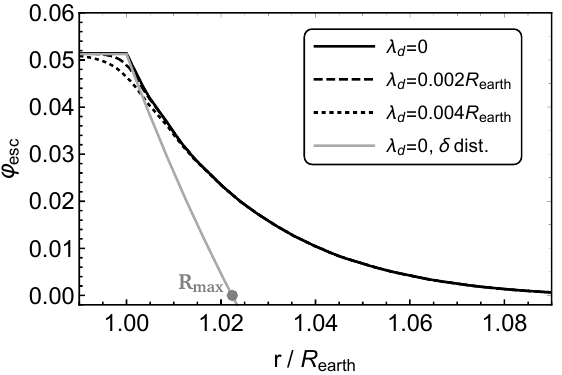
Figure 9 . Mirror electric potential ϕ esc ( r ) in the disk case for (cid:15) = 10 − 11 (the small charge accumulation regime), showing the effects of mirror helium capture inside the Earth and screening by the ambient mirror plasma. Shown are the solutions for ϕ ( r ) for a delta function distribution and for a Maxwell-Boltzmann distribution of speeds at infinity, in the limit that the Debye length λ D = 0 . Also shown is ϕ esc ( r ) in the case of a Maxwell-Boltzmann distribution for two nonvanishing values of λ , showing how the potential is smoothed out. (The actual transition region is extremely D narrow as λ 10 − 3 R D < Earth